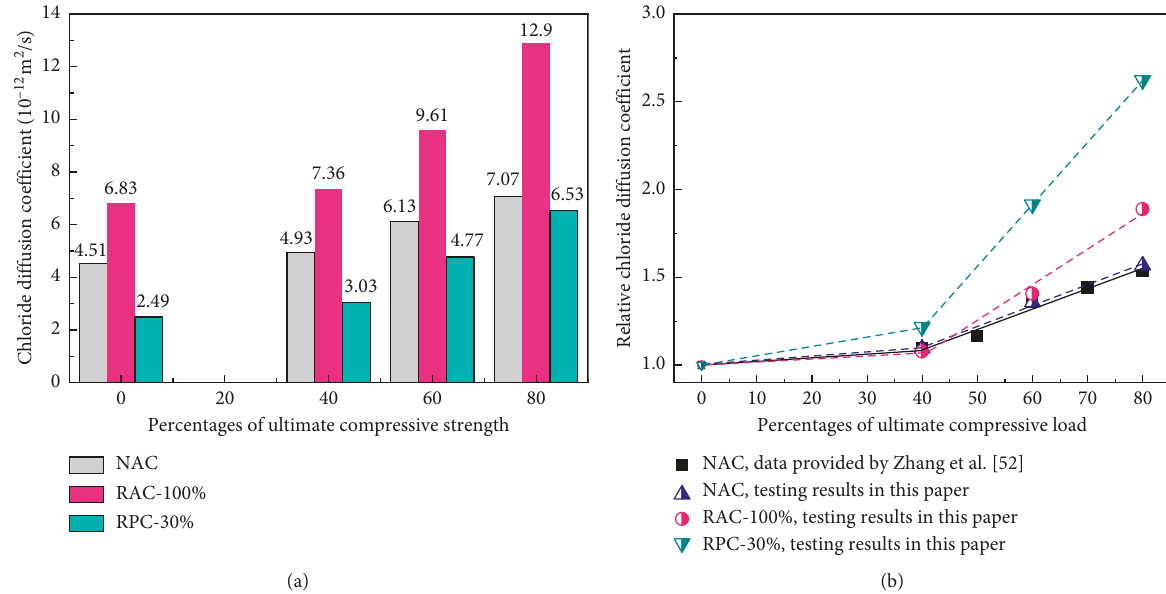
Figure 13: (a) A comparison of the chloride diffusivity of RAC and RPC with various applied loads. (b) A comparison of the results on chloride diffusivity in this paper with those in Zhang et al.